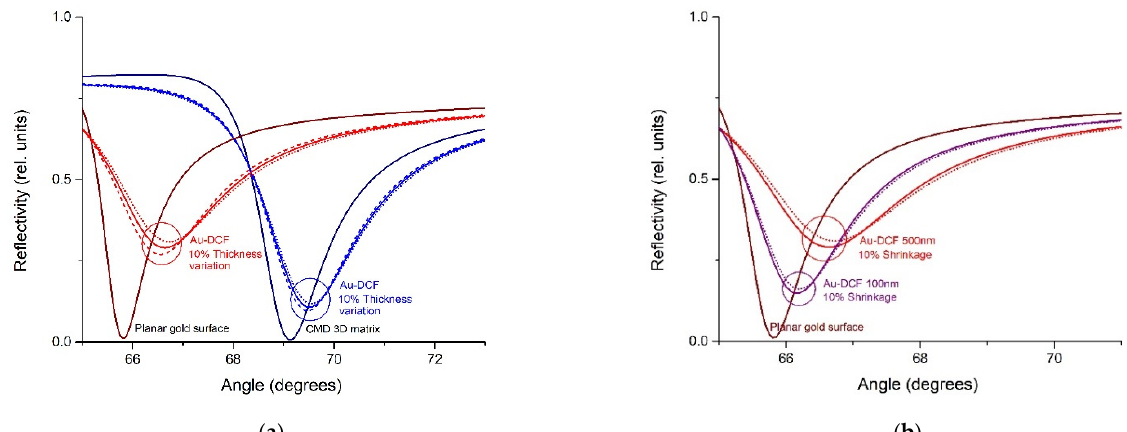
Figure 3. ( a ) Theoretical SPR curves on planar gold surface (dark red) and CMD-coated gold surface (dark blue); the addition of Au-DCF shifts the SPR curve minimum to higher angles: coated planar gold surface (continuous red line), coated CMD (continuous blue line); dotted and dashed lines show the effect of the ±10% variation of the thickness of dynamer; ( b ) Theoretical SPR curves on planar gold surface (dark red) covered with a layer of 100 nm Au-DCF (purple) and 500 nm Au-DCF (red). The effect of 10% contraction of the Au-DCF is shown in dotted lines.